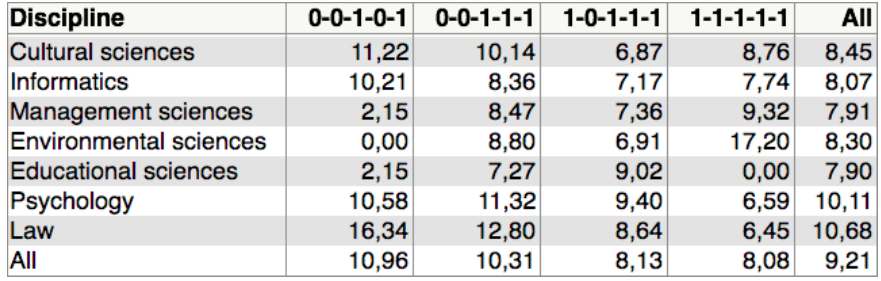
Association of Preference Profiles and the Number of Study Points Attained per Discipline in the Last Year by Enrolled Students